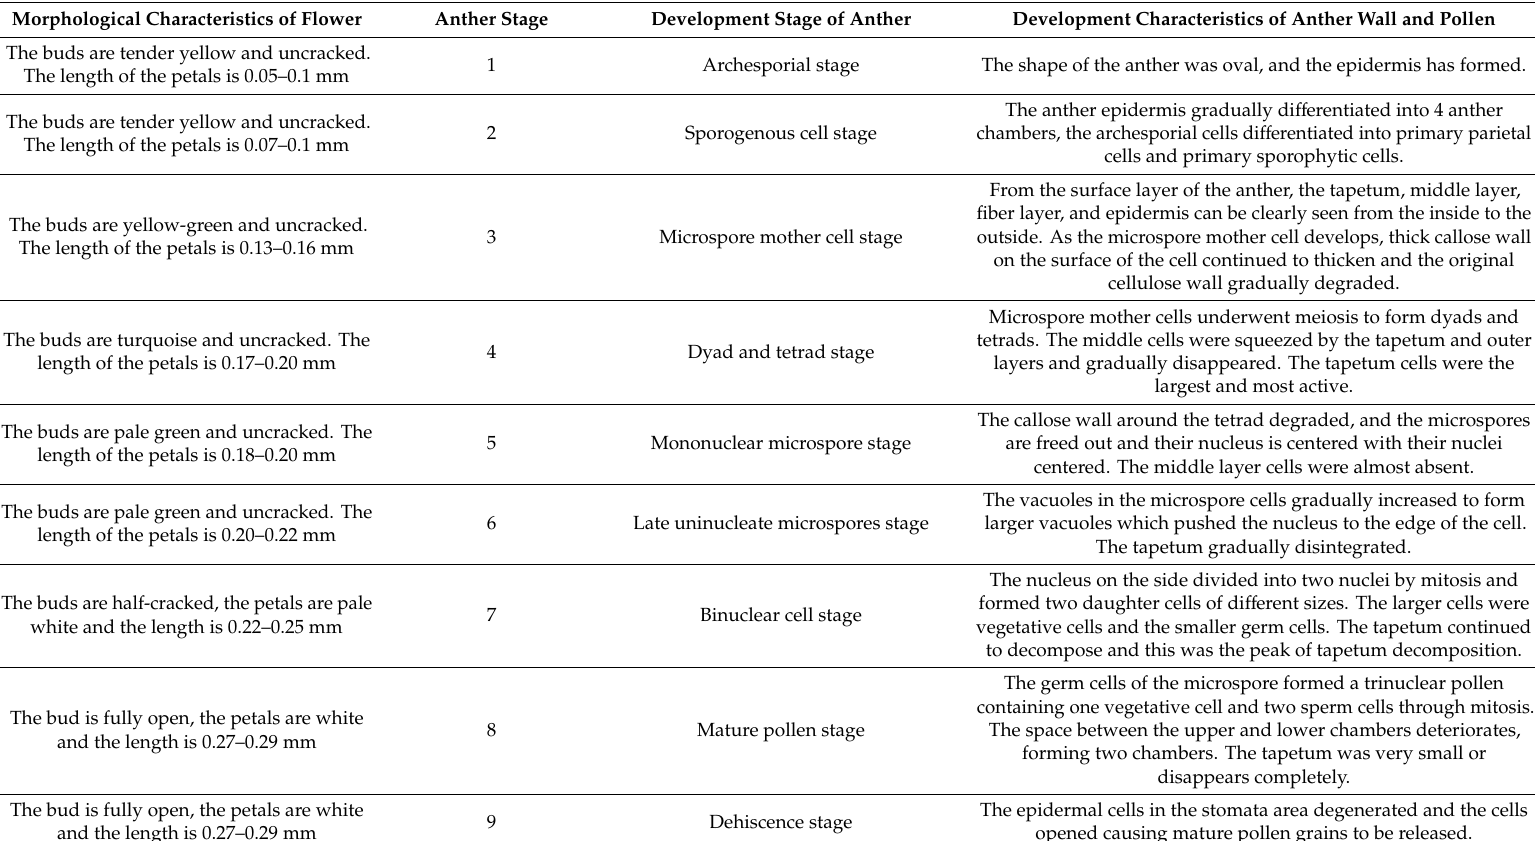
Table 1. Characteristic of developmental stages of celery